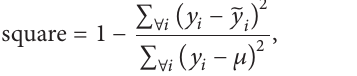
determined, including SSE (4), RMSE (5), R -square (6), and adj- 𝑅 -square